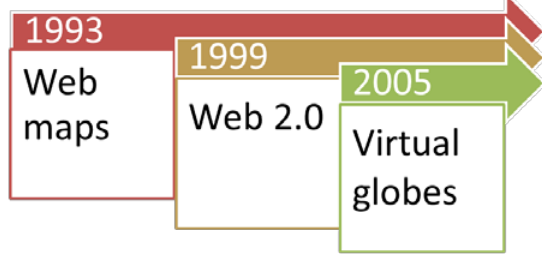
Figure 2: Map developments on the